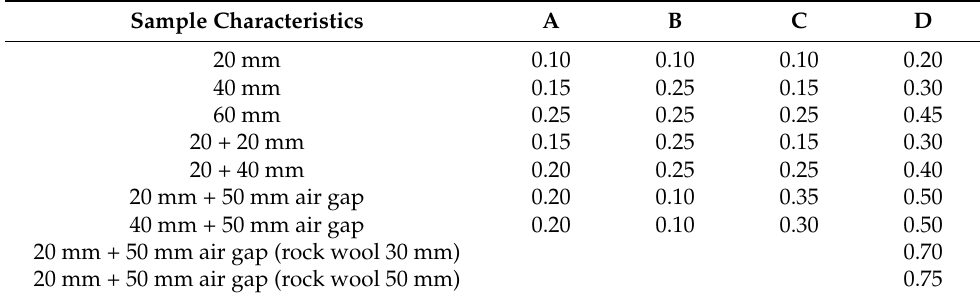
Table 3. Comparison of single acoustic indices related to the weighted absorption coefficient ( α w ) for the four concrete types